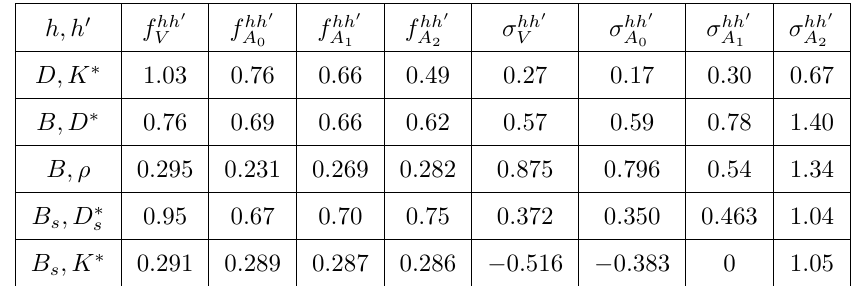
Table 13 . First part of the table with parameters of meson form factors (C.28){(C.30) of decay into vector meson [112{114].